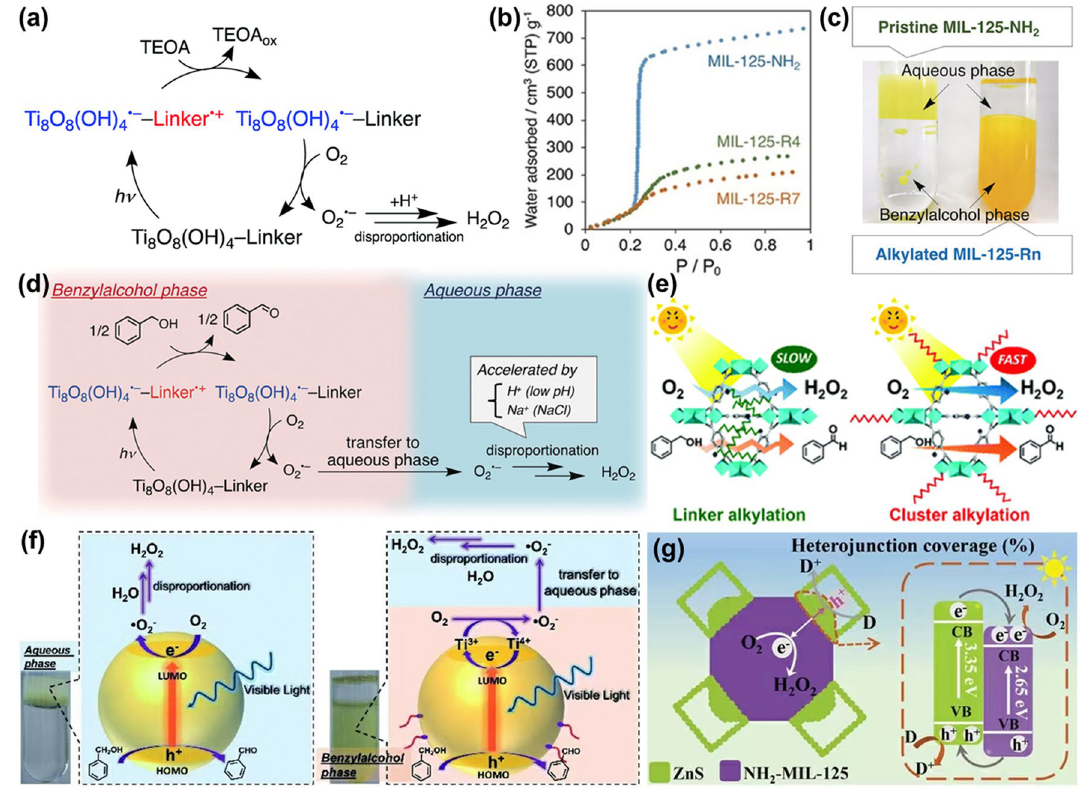
Fig. 11 a Photocatalytic mechanism of H 2 O 2 formation on the MIL-125-NH 2 photocatalyst. Reproduced with permission from Ref. [180]. Cop- yright 2018 ROYAL SOCIETY OF CHEMISTRY. b Water adsorption isotherms for various catalysts. c Digital photographs utilizing the two- phase system. d Mechanism illustration of H 2 O 2 generation by the two-phase system. Reproduced with permission from Ref. [181]. Copyright 2019 Wiley–VCH Verlag GmbH & Co. KGaA, Weinheim. e Photocatalytic processes of MIL-125-R7 and OPA/MIL-125-NH 2 photocatalysts. Reproduced with permission from Ref. [182]. Copyright 2019 ROYAL SOCIETY OF CHEMISTRY. f Mechanism of photocatalytic H 2 O 2 pro- duction using the Zr 100 -MOF and OPA/Zr 92.5 Ti 7.5 -MOF photocatalyst. Reproduced with permission from Ref. [183]. Copyright 2020 ROYAL SOCIETY OF CHEMISTRY. g Photocatalytic O 2 reduction to H 2 O 2 over a NH 2 -MIL-125@ZnS heterojunction. Reproduced with